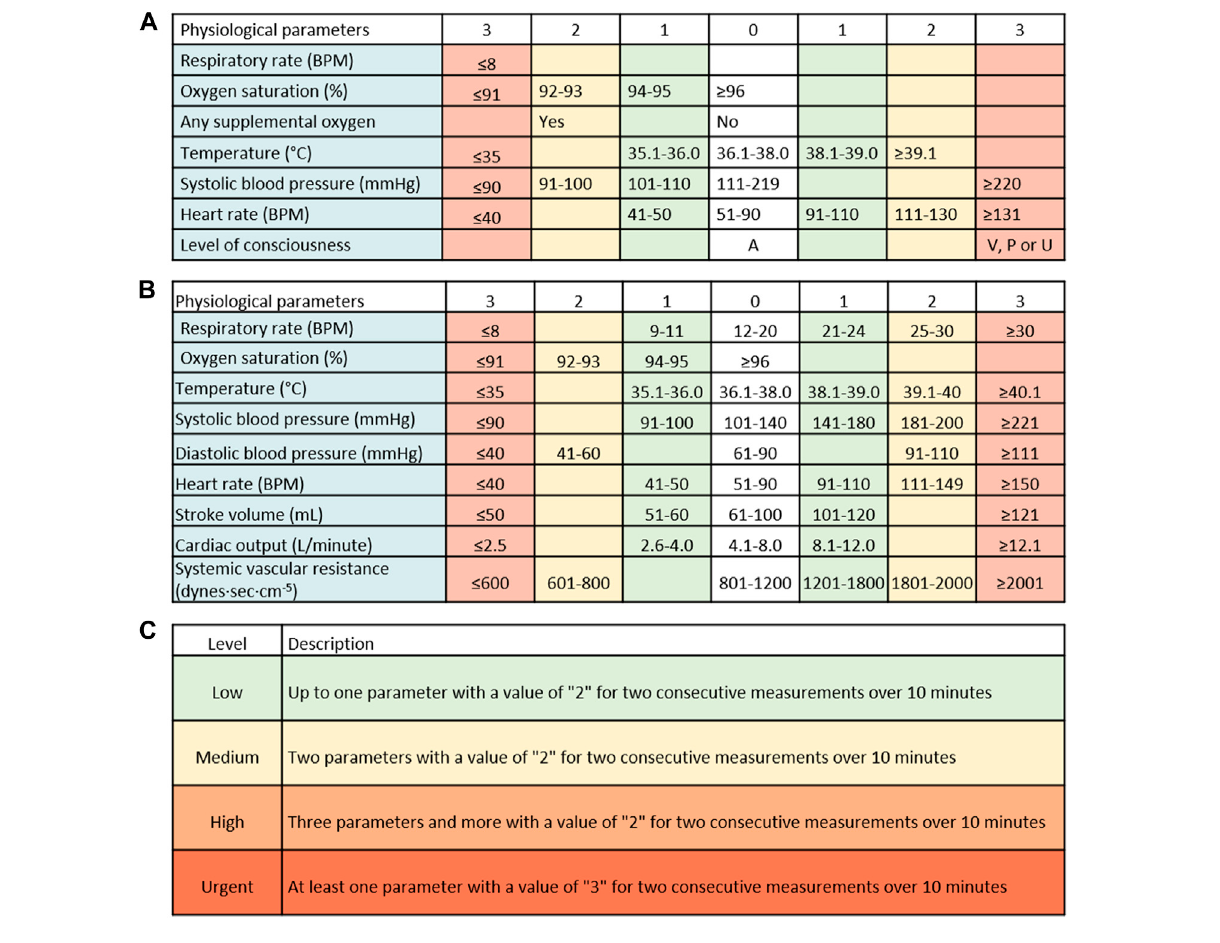
FIGURE 1 The currently-used National Early Warning Score (NEWS) and the new tool. (A) The NEWS score is comprised of systolic blood pressure, heart rate, oxygen saturation, respiratory rate, and temperature, each with a de fi ned risk level ranging from 0 to 3. Another feature is de fi ned as the “ Red score ” , which should result in an immediate check-up of the patient, though the score is not provided in real-time. (B) The new score includes 9 vital signs: systolic blood pressure, diastolic blood pressure, heart rate, oxygen saturation, respiratory rate, temperature, stroke volume, cardiac output, and systemic vascular resistance, each with a de fi ned risk level ranging from 0 to 3. (C) The new early warning score integrates the risk levels of each parameter with atime element,i.e., atleasttwoconsecutivemeasurements overa10-minperiod.RPM – respirationsperminute; BPM – beats